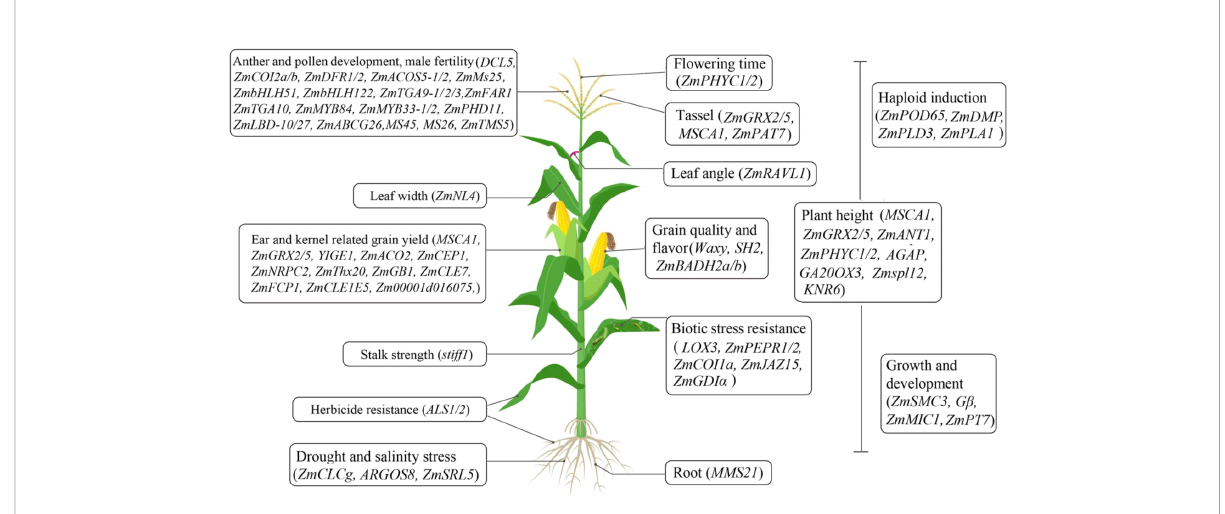
FIGURE 1 A schematic of the CRISPR-Cas technology used for the functional genomics study and generation of new germplasms in